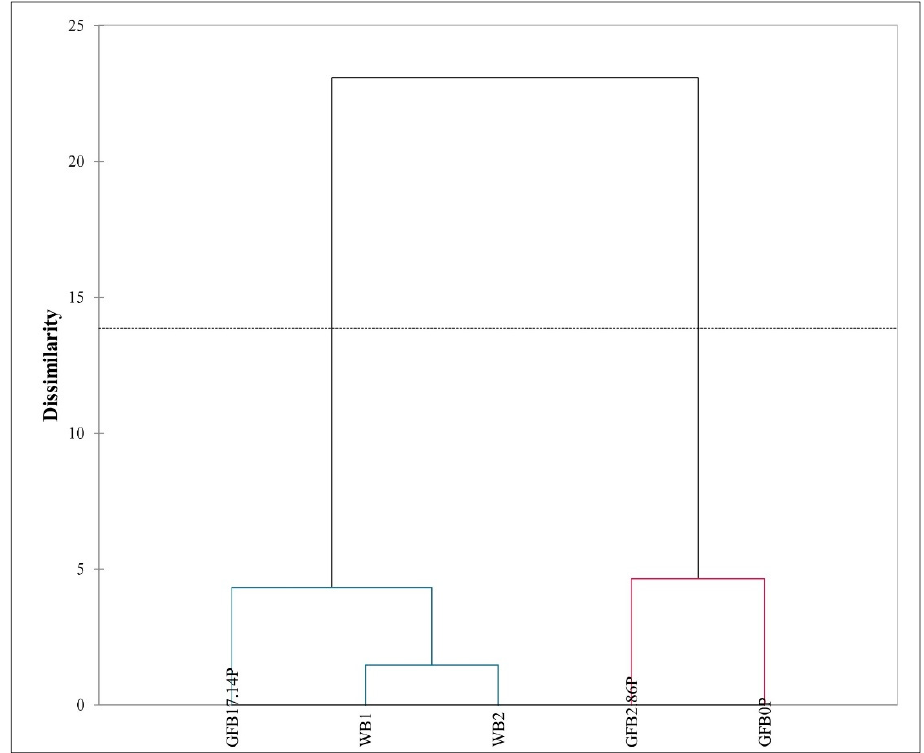
Figure 5. Dendogram obtained by hierarchical cluster analysis for data of gluten-free bread with (GFB2.86P and GFB17.14P) and without (GFB0P) psyllium in comparison to wheat bread (WB1 and WB2).